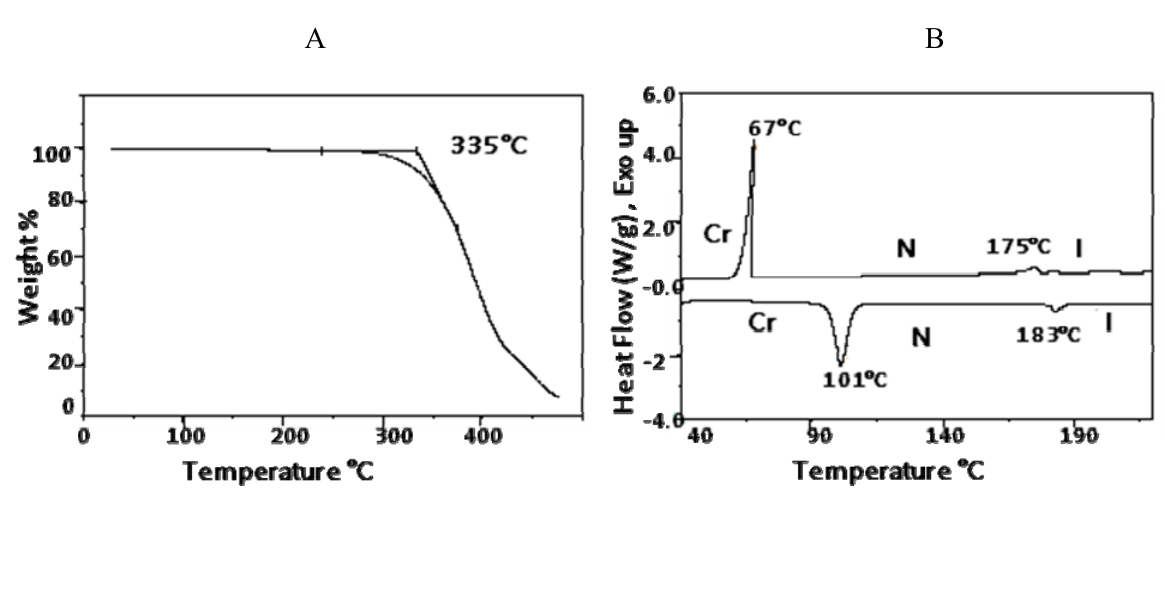
Figure 10. (10A) Thermogravemetric analysis of benzoic acid, 4-(4-pentenyloxy)-, 2- methyl-1,4-phenylene ester ( 7 ). (10B) DSC thermograms for benzoic acid, 4-(4- pentenyloxy)-, 2- methyl-1,4-phenylene ester ( 7 ). A